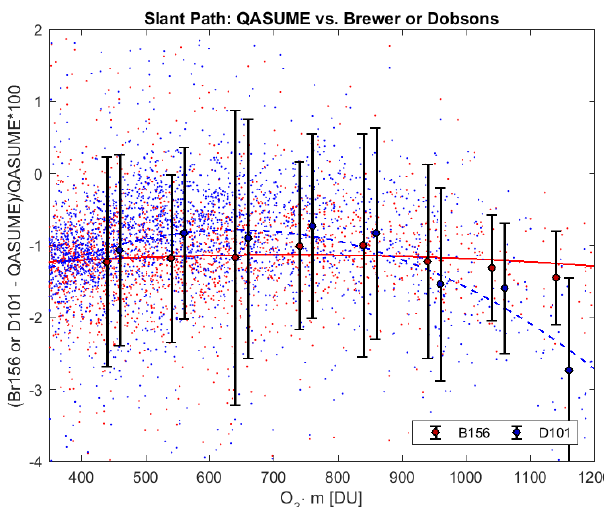
Figure 8. Differences of Brewer 156 and Dobson 101 retrieved with SG14 cross section compared with QASUME TCO depending on the ozone slant path. The comparison with Brewer shows negligible stray-light